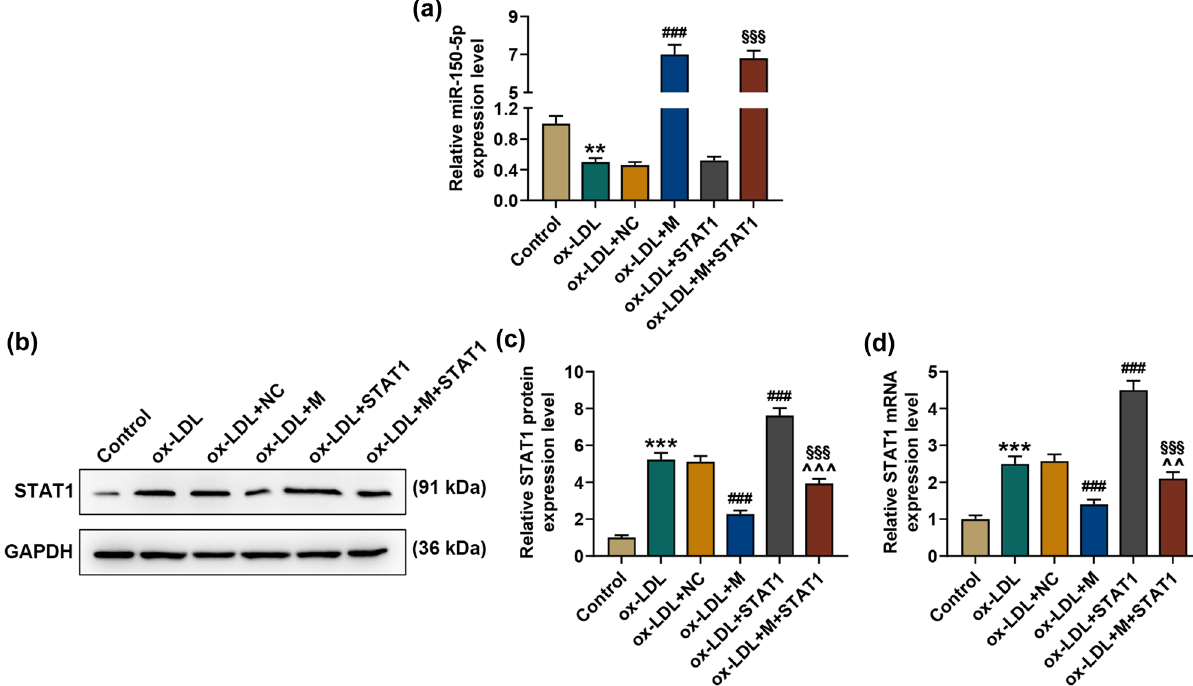
Figure 3: miR - 150 - 5p regulated the expression of STAT1 in ox - LDL - stimulated HASMCs. ( a ) The relative expression of miR - 150 - 5p was detected by qRT - PCR. U6 snRNA was used as the internal reference for normalization of miR - 150 - 5p levels. ( b ) – ( d ) The relative expression of STAT1 was detected by qRT - PCR and Western blot. GAPDH was used as the internal reference. ** p < 0.01, *** p < 0.001 vs Control; ### p < 0.001 vs ox - LDL + NC; ^^ p < 0.01, ^^^ p < 0.001 vs ox - LDL + M; §§§ p < 0.001 vs ox - LDL + STAT1. qRT - PCR: quantitative reverse transcription - polymerase chain reaction; ox - LDL: oxidized low - density lipoprotein; M: miR - 150 - 5p mimic; NC: negative control ( empty vector ) . All these experiments were performed three times